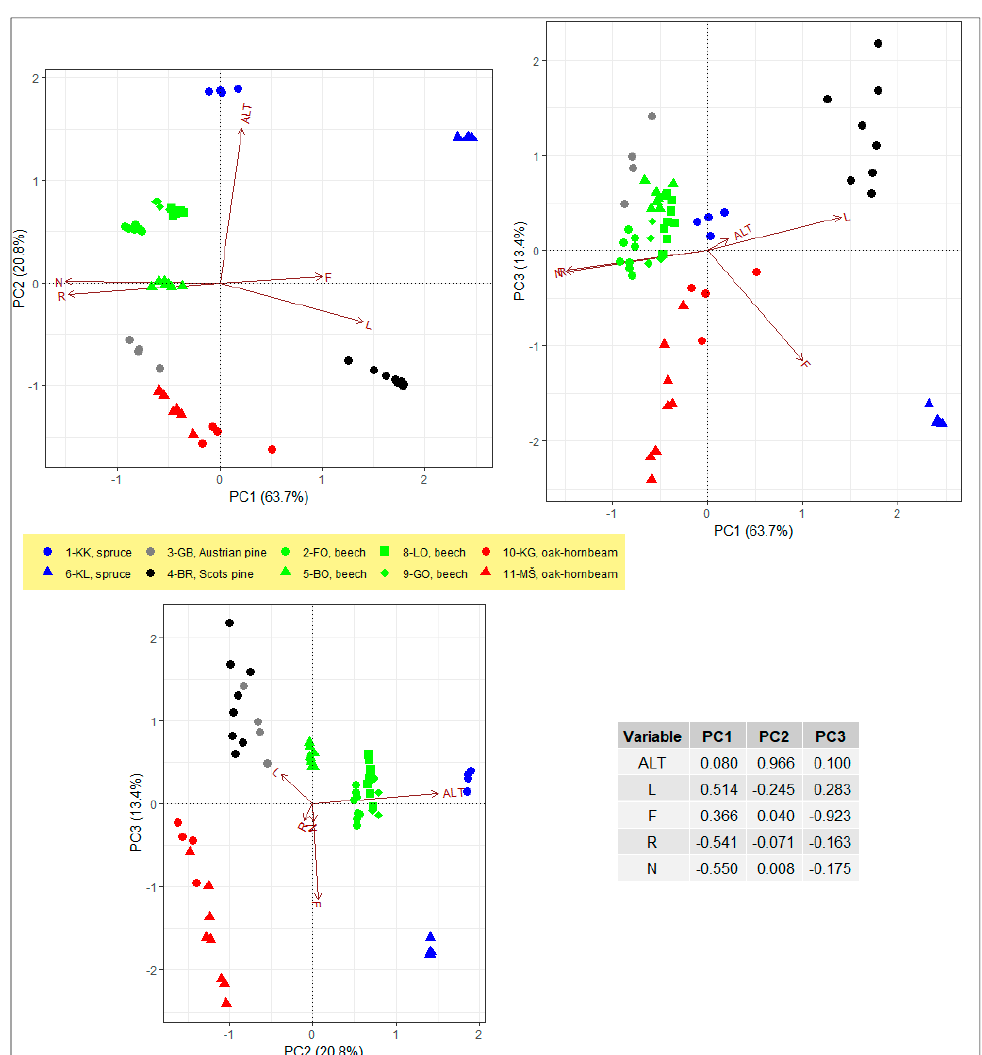
Figure 2. Principal component analysis (PCA) ordination diagrams for 10 IM sites in Slovenia, based on five environmental variables: ALT = altitude, L = Ellenberg Indicator Value (EIV) for light, F = EIV for soil moisture, R = EIV for soil reaction, N = EIV for soil nutrients. The EIVs were calculated based on presence/absence data from all vegetation, including the tree, shrub and herb layer. Results are shown for large vegetation plots (Lplots, 10 × 10 m, 60 plots in total). The bottom right table shows Pearson’s correlation coefficients between the environmental variables and the three PCA axes (PC1, PC2, PC3).